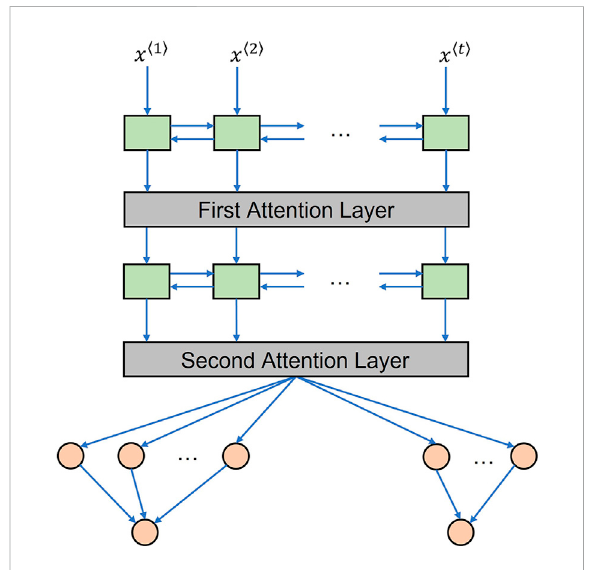
FIGURE 4 Attention deep learning model with Bi-LSTM.